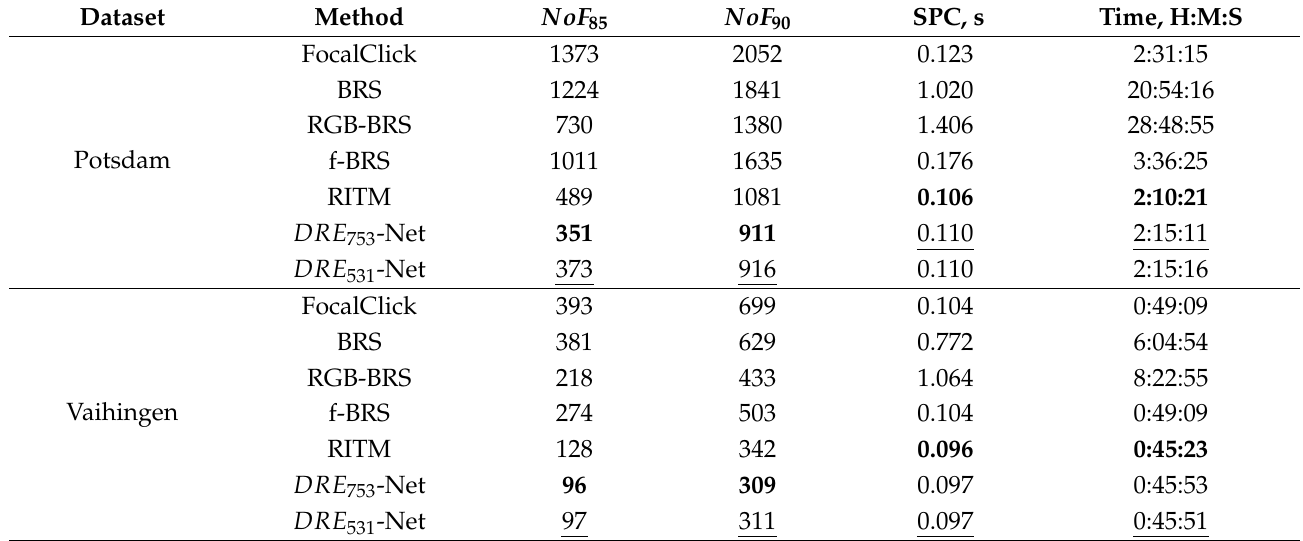
Table 4. Evaluation results for the NoF metric and the inference speed on the Potsdam dataset and Vaihingen dataset. NoF 85 / NoF 90 indicates the number of failures to reach the target IoU of 85%/90% within 20 clicks. SPC indicates the average running time in seconds per click, and the time measures the total running time taken to process a dataset. (The best is bolded and the runner-up is underlined).